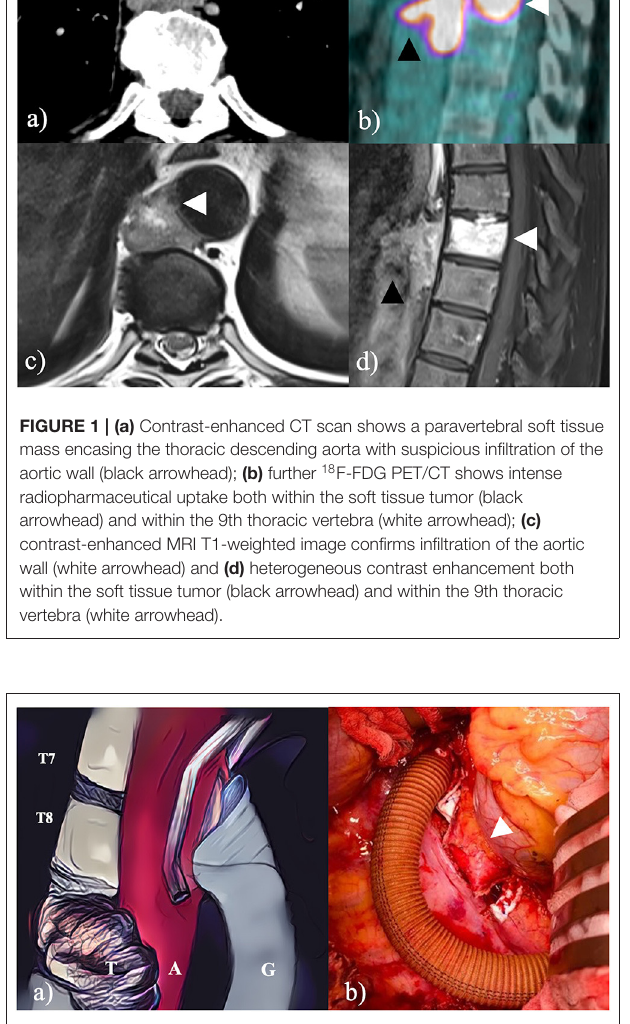
be undermined by neoadjuvant chemotherapy. Tomita et